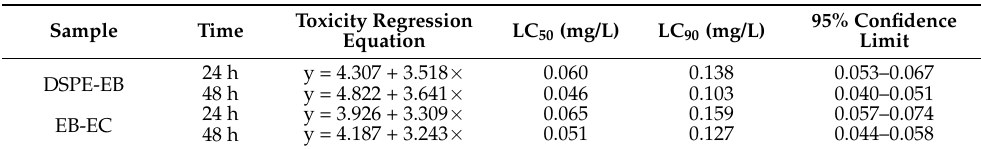
Table 1. Indoor toxicity results of DSPE-EB nanoparticles and EB-EC against the third-instar S. furgiperda larvae.